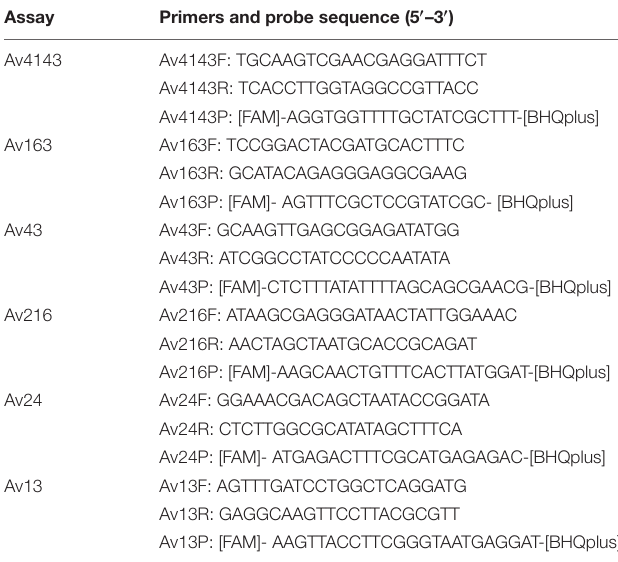
TABLE 1 | Primers and probes of MST qPCR assays used in the study. Assay Primers and probe sequence (5 (cid:48) –3 (cid:48) )